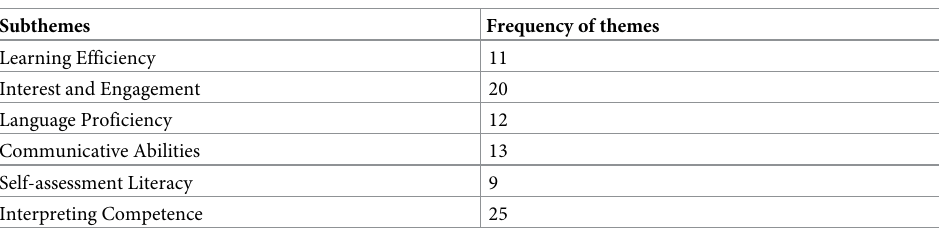
Table 7. Subthemes of gains from informal learning.